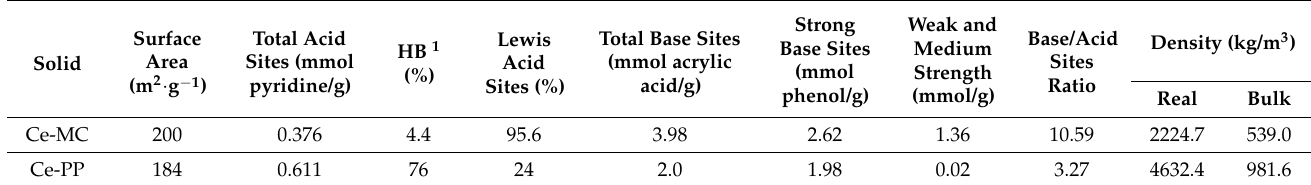
Table 4. Surface area, density, acidity, and basicity of the calcined Ce-modified LDHs.